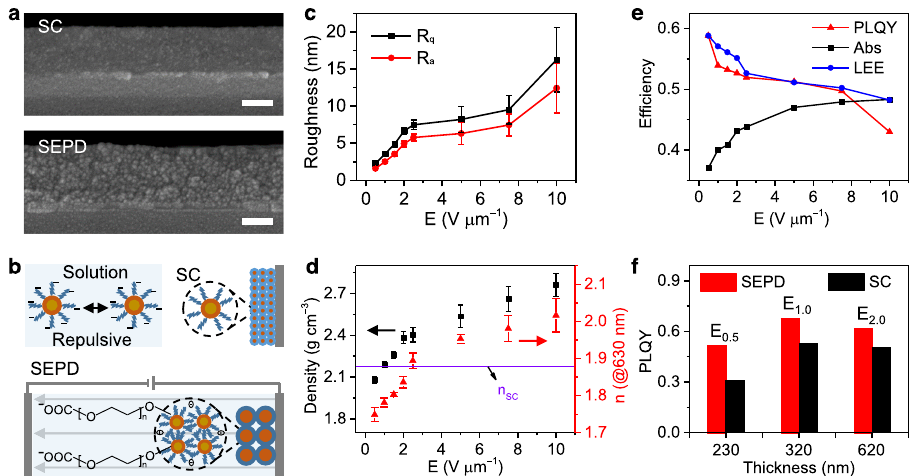
Fig. 2 Characteristic control of QD patterns. a Cross-sectional SEM images of QD fi lms prepared by spin coating (SC) and SEPD. Scale bars, 100 nm. b Illustration for the formation mechanism of SEPD QDs fi lm. In polar solvents, ligands dissociate from the surface and form the repulsive interaction between particles responsible for colloidal stabilization. When the electric fi eld is applied, charged particles are driven to move to the electrodes of opposite polarity and the repulsive forces between the particles will be overcome by the electric fi eld. Then particle aggregation occurs due to the attractive hydrogen-bonding interaction. R q (root mean square roughness ( c ), black line), R a (roughness average ( c ), red line) values, density ( d , black square), and n @630 nm ( d , red triangle) of the QD fi lms fabricated by SEPD at different electric fi elds ( E ). Error bars indicate standard deviations of the measured values from several samples. e Abs and PLQYs of QD fi lms fabricated by SEPD at different electric fi elds, whose change is consistent with the simulated light extraction ef fi ciency (LEE, blue line). f PLQY comparison between QD fi lms with different thicknesses fabricated by SC and SEPD under an electric fi eld of 0.5, 1.0, and 2.0 V μ m − 1